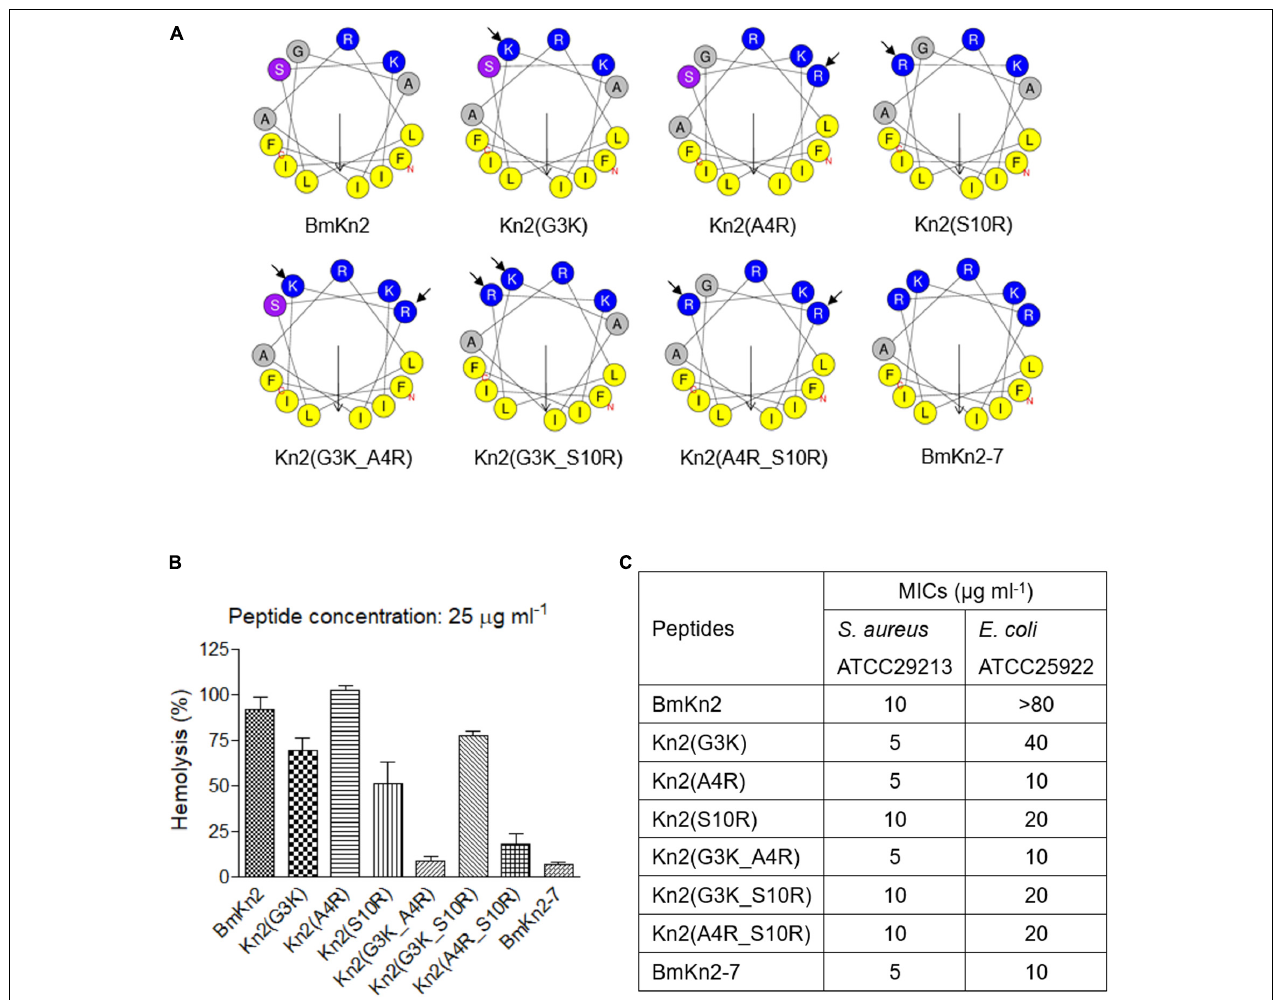
FIGURE 2 | Design, hemolytic and antimicrobial activity analyses of BmKn2 analogs. (A) Helical-wheel projections of BmKn2, BmKn2-7 and the designed peptides. (B) The percent hRBC hemolysis at 25 µ g ml - 1 was determined for BmKn2, BmKn2-7 and the designed peptides. The absorbance of the supernatants was measured at 540 nm to evaluate the release of hemoglobin. (C) The antimicrobial activities (MIC in µ g ml - 1 ) were determined against Staphylococcus aureus ATCC29213 and Escherichia coli ATCC25922. All experiments were repeated at least three